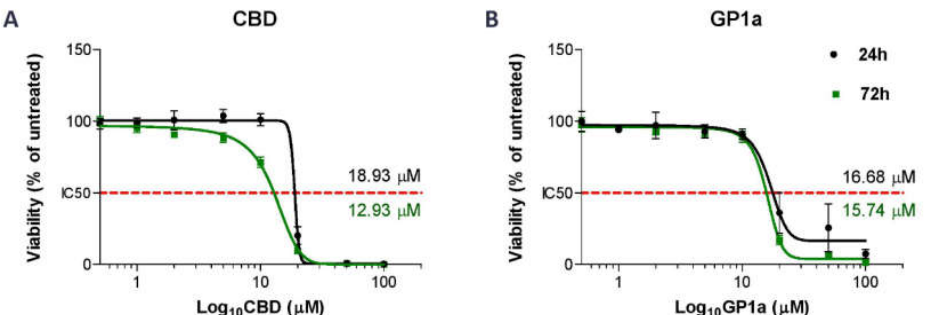
Figure 2. Half-maximal inhibitory dose (IC50) values of CBD- and GP1a-treated SV-HUC1 cells. SV-HUC1 were treated with increasing concentrations of CBD ( A ) or GP1a ( B ) (0, 0.5, 1, 2, 5, 10, 20, 50, 100 µM) for 24 h and 72 h and analysed with ATP viability assay. The data are normalized to the corresponding non-treated control cells (set to 100%). The mean ± SD values of three independent experiments performed in triplicates are presented. Nonlinear regression analysis of the mean cytotoxicity values of CBD and GP1a was used for IC50 determination (indicated with red dotted line). 2.3. CBD Reduces the TNFα-Driven Release of Pro-Inflammatory Mediators from Urothelial Cells through Inhibition of NFκB Activation